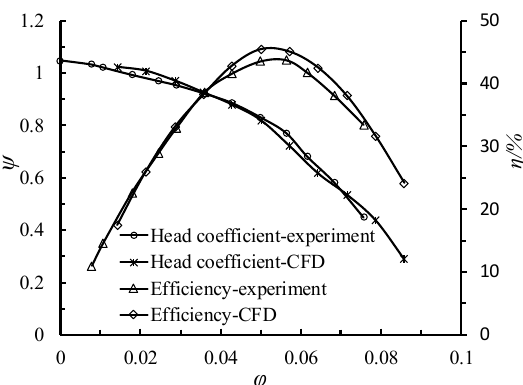
Figure 12. Hydraulic characteristics of numerical calculation and experiment.